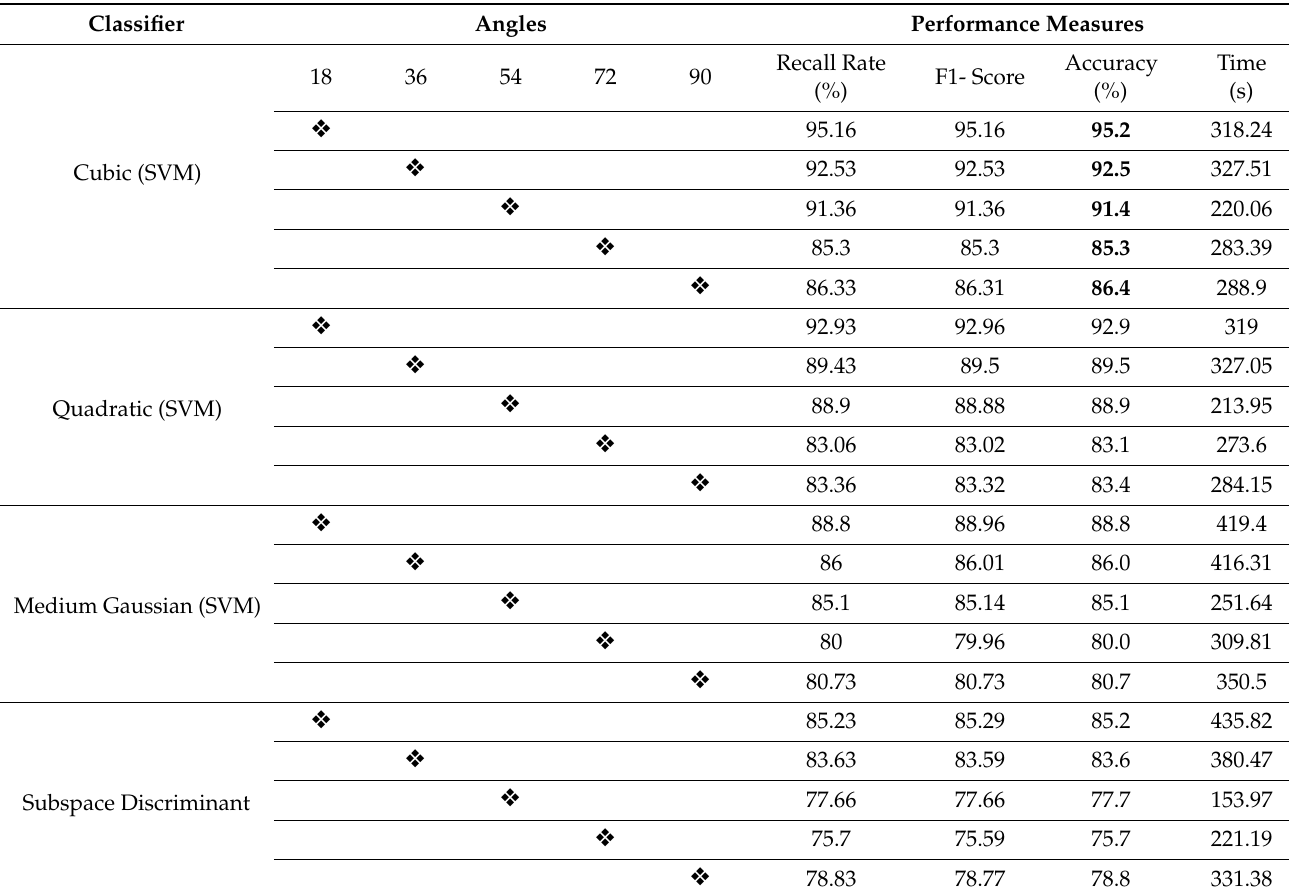
Table 3. Gait recognition results using modified NasNet-Mobile on selected angles of the non-augmented CASIA B da- taset.